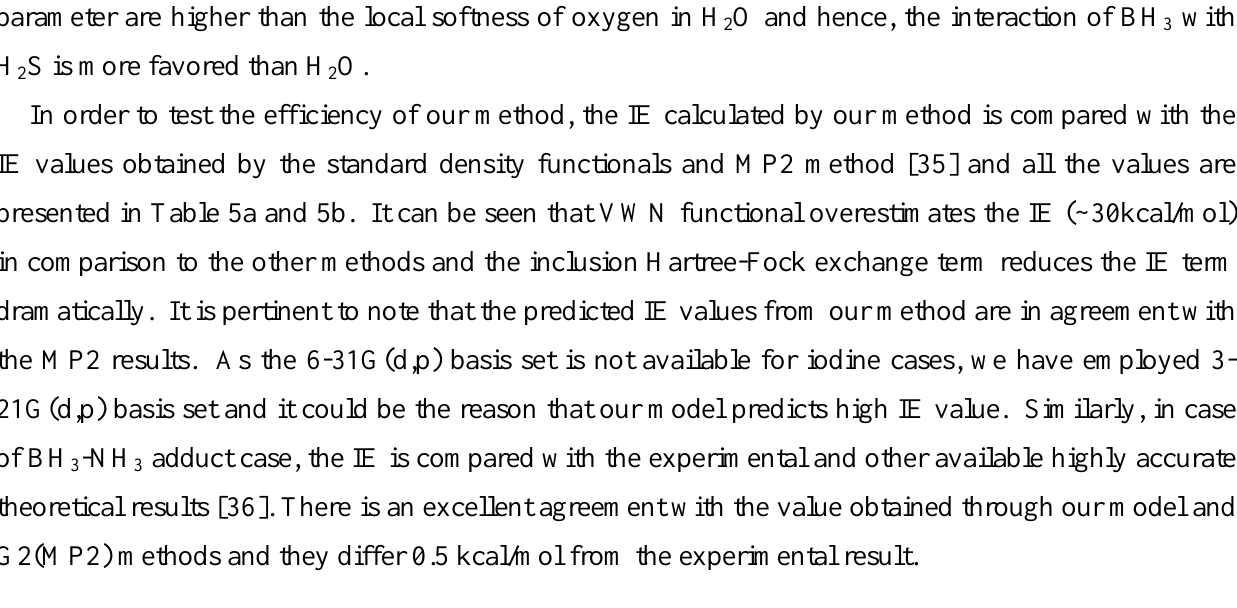
-X complexes obtained by our method 3 2